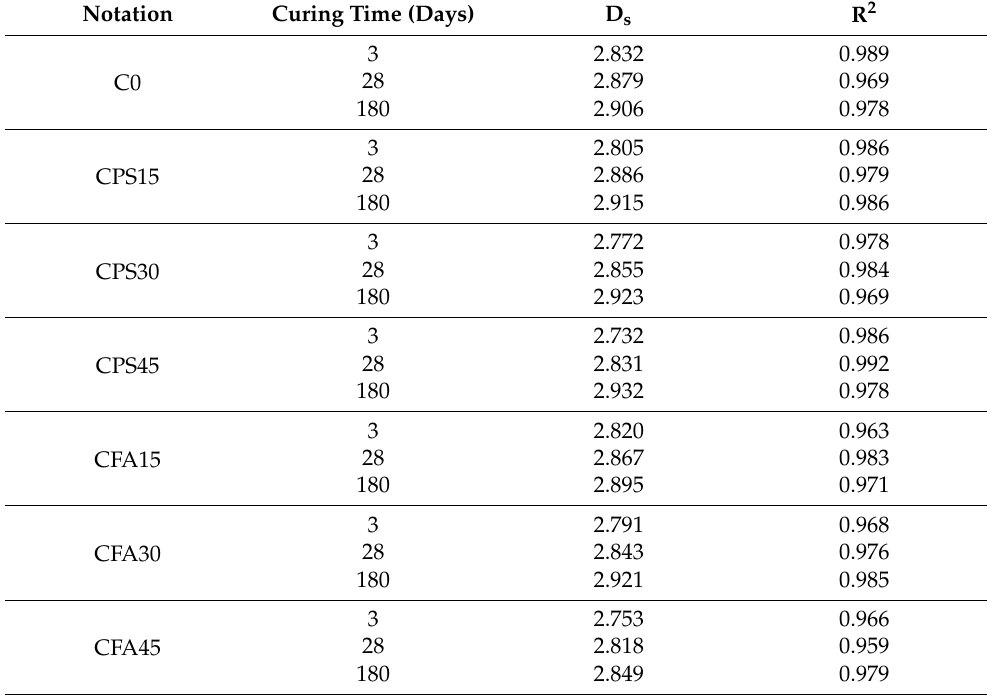
Table 6. D s of hydraulic concretes added with FGPS and fly